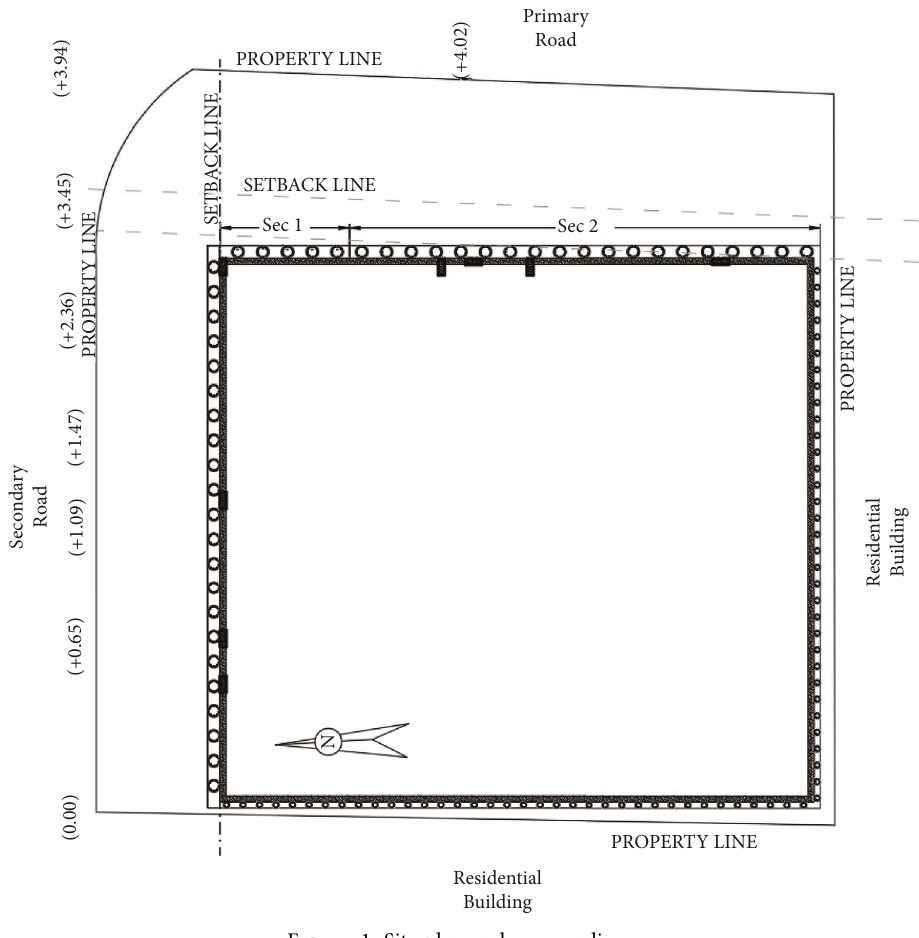
Figure 1: Site plan and